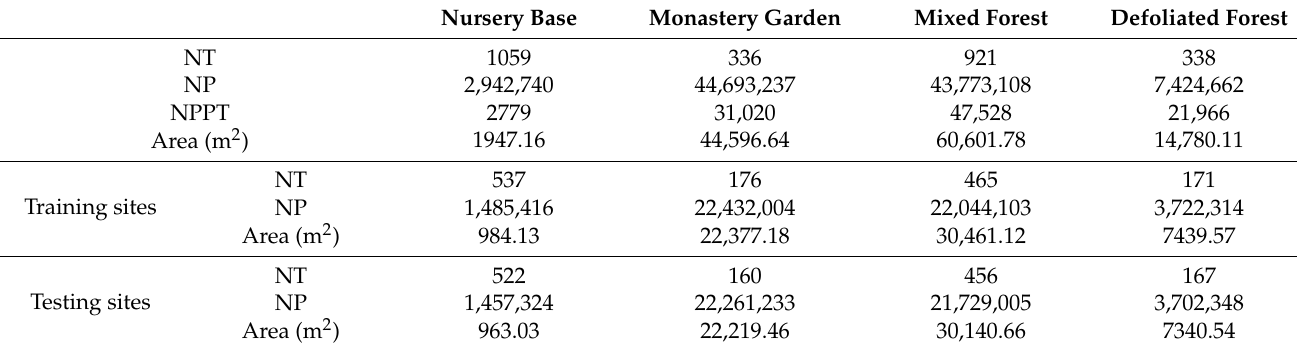
Table 1. A detailed description of the dataset for our deep learning method. Nursery